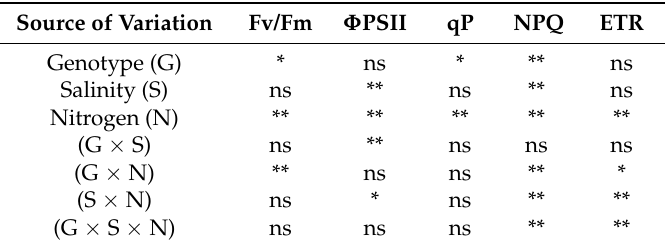
Table 6. Summary of analysis of variance for maximum quantum efficiency of PSII (Fv/Fm), non-photochemical quenching (NPQ) and electron transfer rate (ETR) at the flowering stage in